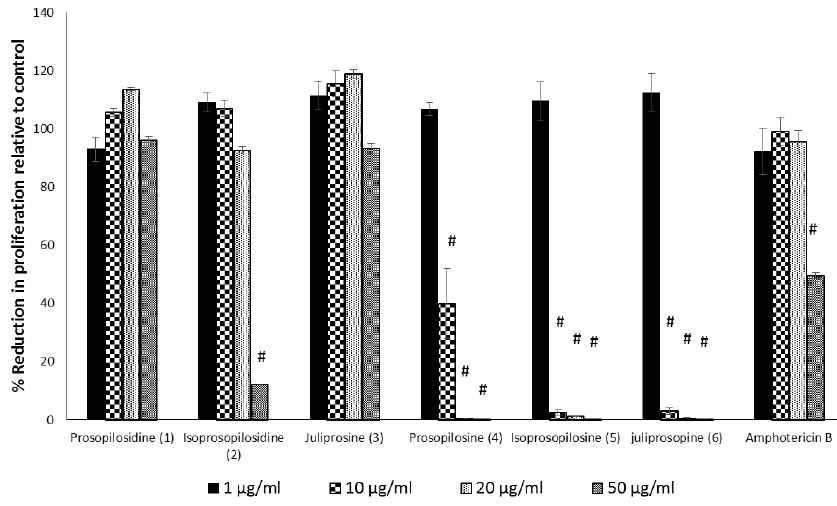
Figure 2. The effect of different compounds, prosopilosidine ( 1 ), isoprosopilosidine ( 2 ), juliprosine ( 3 ), prosopilosine ( 4 ), isoprosopilosine ( 5 ), juliprosopine ( 6 ) and Amphotericin B (Amp B) on cell viability. HepG2 cells were seeded on 96-well plates and were treated with 1, 10, 20, and 50 µg/mL of the test compounds or with vehicle only for 24 h. The MTS assay for cell viability and proliferation was performed with the CellTiter 96 ® AQueous Non-Radioactive Cell Proliferation Assay Kit (Promega). Data are shown as mean ± SEM and were analyzed with ANOVA. # p < 0.001 is considered statistically significant compared to the untreated cells (100%).